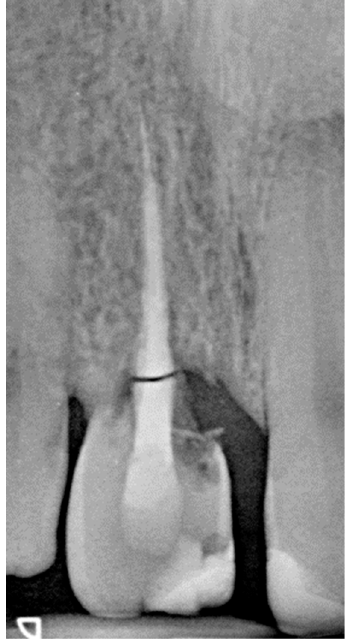
Figure 10. Rx at the 16-year recall visit.